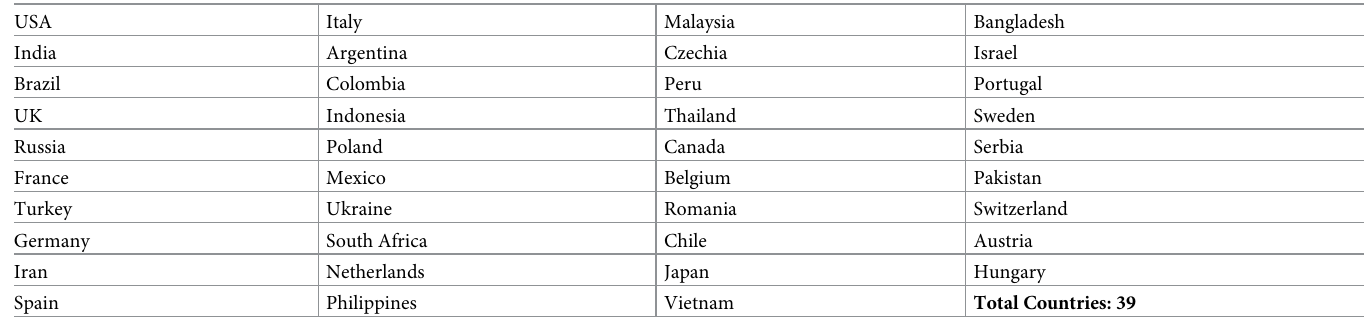
Table 1. List of